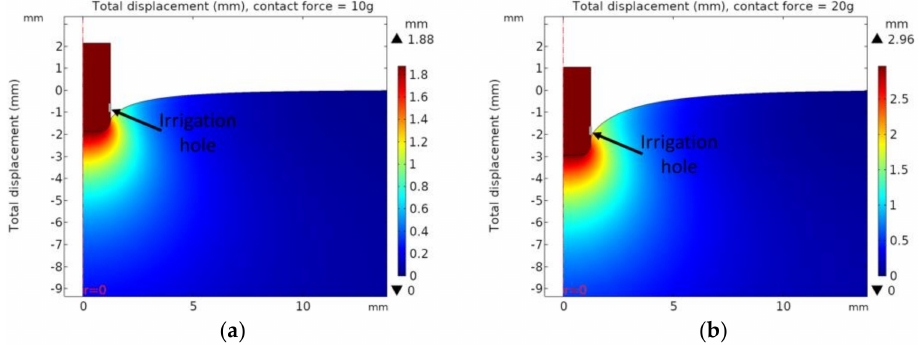
Figure 6. Displacement distribution with catheter diameter of 7.5 Fr. ( a ) contact force = 10 g, ( b ) contact force = 20 g, ( c ) contact force = 30 g, ( d ) contact force = 40 g.